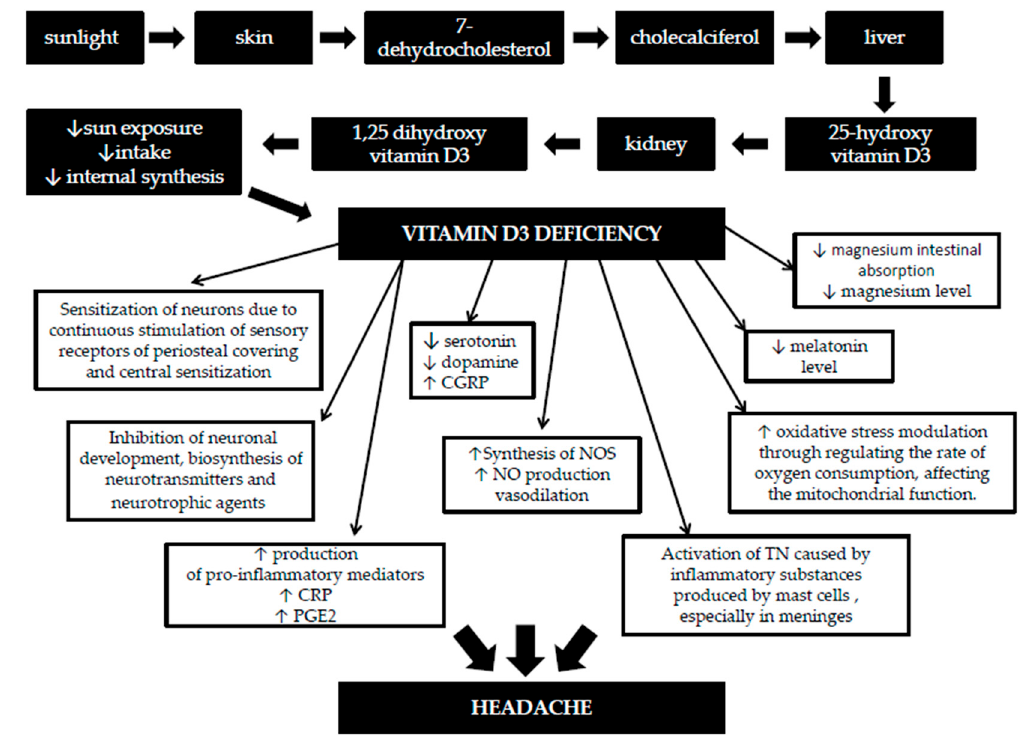
Figure 1. Potential role (s) that vitamin D deficiency can play in headache. Abbreviations: CGRP— calcitonin gene-related protein, NO—nitric oxide, NOS—nitric oxide synthase, CRP—C-reactive protein, PGE2—prostaglandin E2, TN—trigeminal nerve, ↓ —a decrease, ↑ —an increase.